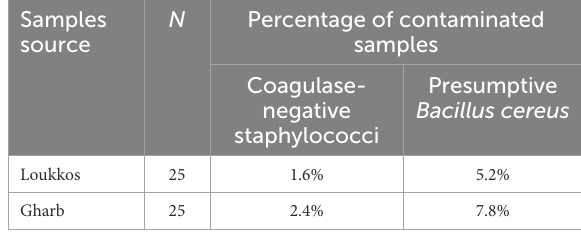
TABLE 3 Prevalence (%) of presumptive Bacillus cereus and coagulase-negative staphylococci in strawberry fruit samples. Samples source